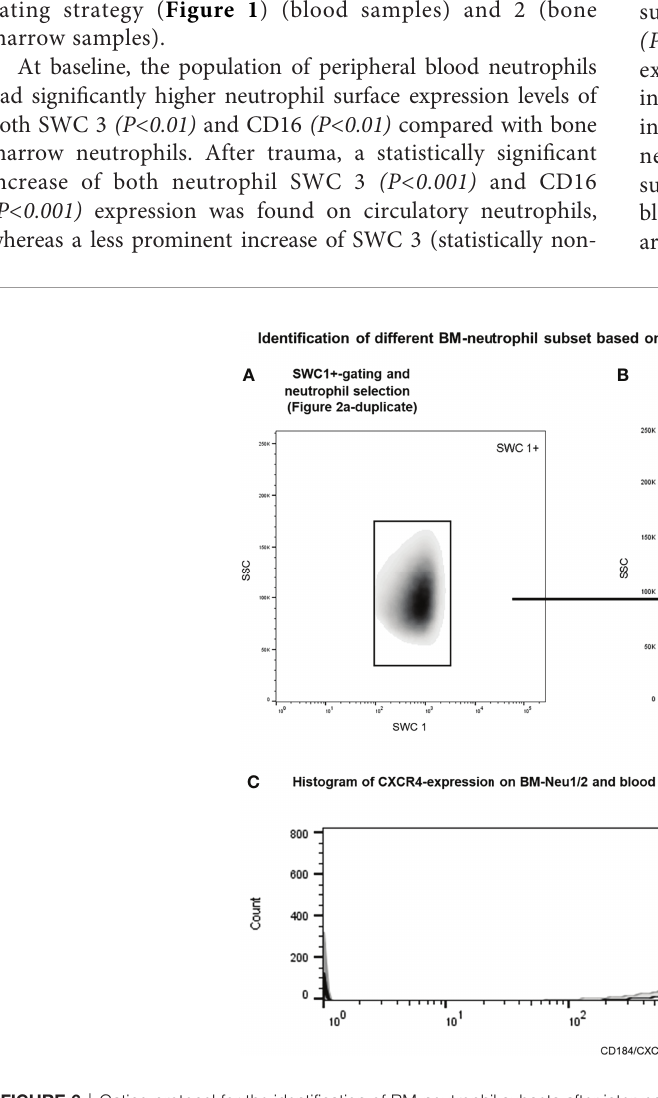
FIGURE 6 | Gating protocol for the identi fi cation of BM-neutrophil subsets after intervention. Initial gating steps have been displayed in Figure 2 . (A, B) Representative example of FACS analysis of porcine bone marrow samples after intervention. (C) Histograms showing regular neutrophils (BM-Neu1, black line), novel FSC high neutrophils (BM-Neu2, grey line) and reference blood neutrophils at termination (grey fi lled curve). MFI, median fl uorescence